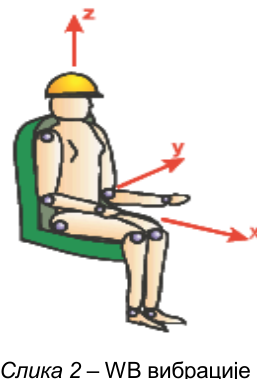
Слика 2 – WB вибрације Рис . 2 – WB вибрации Figure 2 – WB